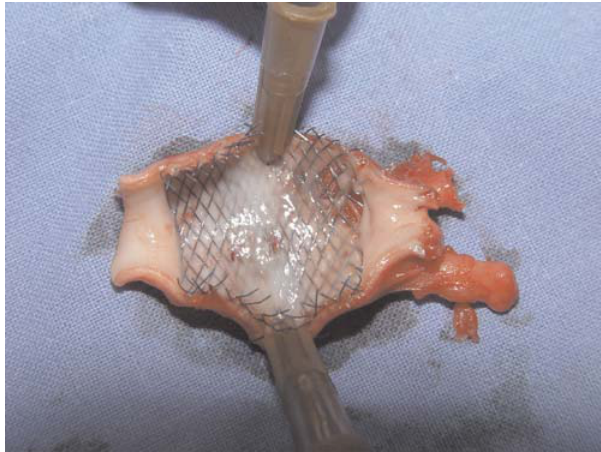
Figure 3 - Macroscopic view of stent in pig aorta in Group M